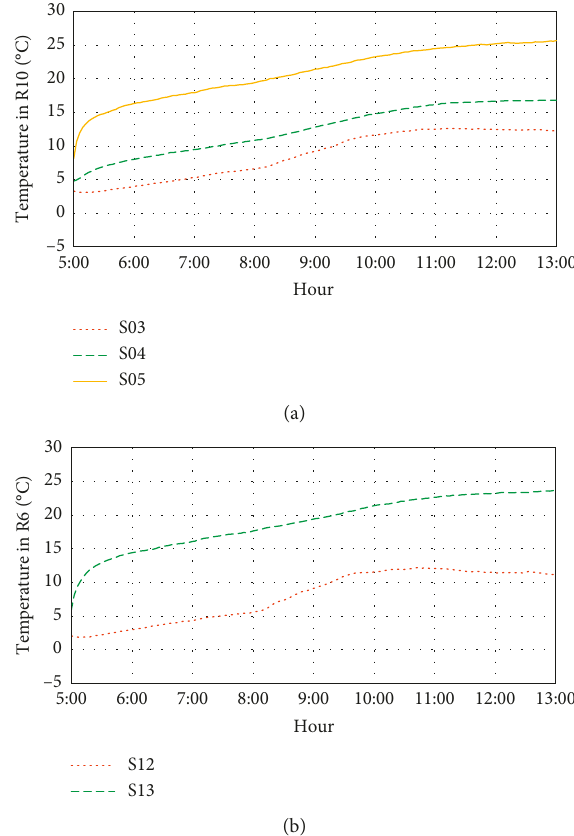
Figure 4: Temperature profile inside the pavement in R10 (a) and R6 (b), recorded by thermistors in S03, S04, and S05 and S12 and S13 from 5.00 to 13.00,